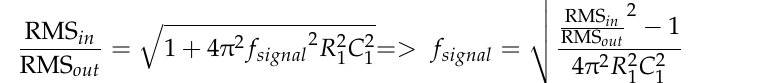
Figure 12. PSpice time integral computation principle.